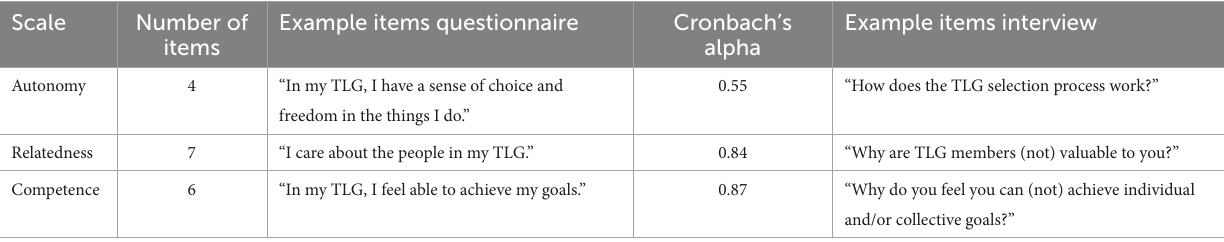
TABLE 3 Reliability and number of items of the quantitative measurement of experienced basic psychological needs via the scales autonomy, relatedness, and competence.